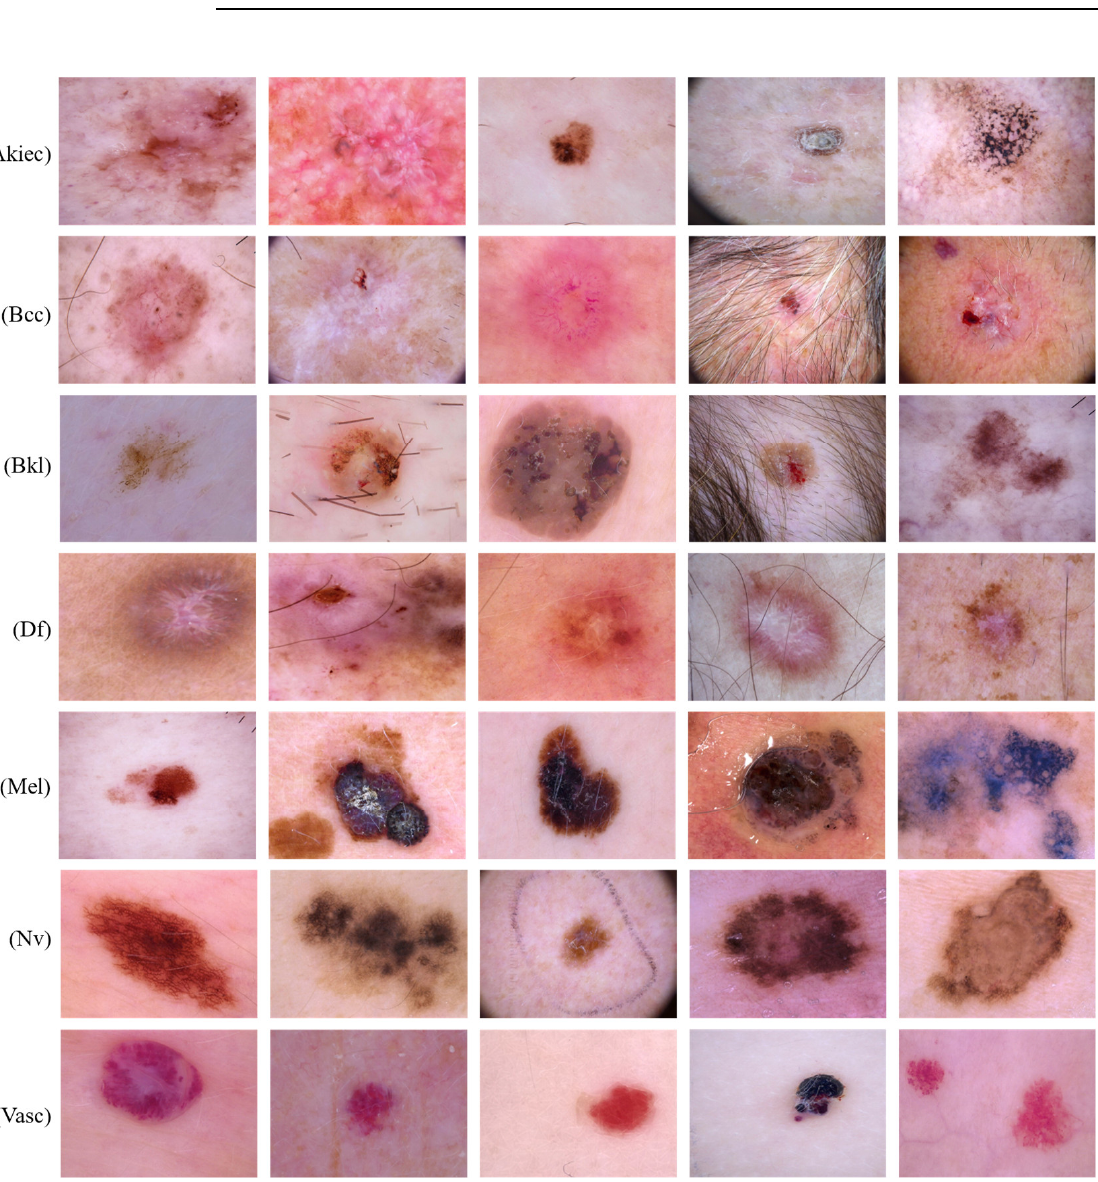
Figure 3. Sample images from the HAM10000 dataset.